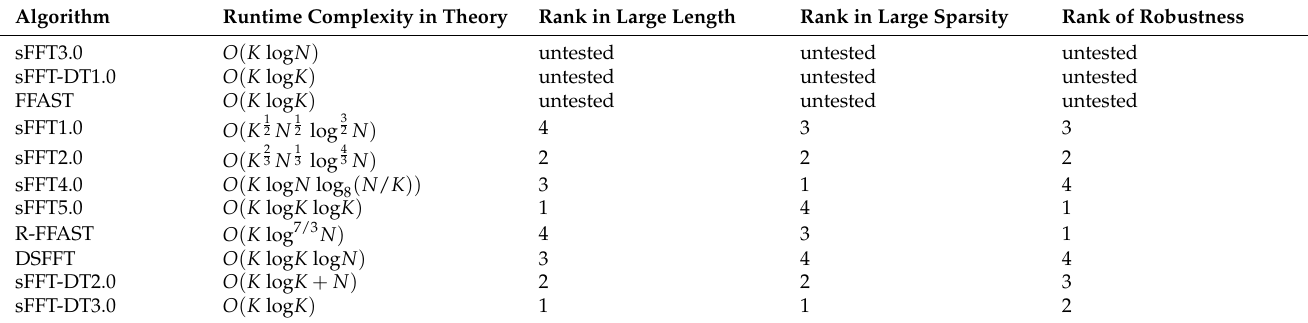
Table 1. The performance of two new algorithms and other sFFT